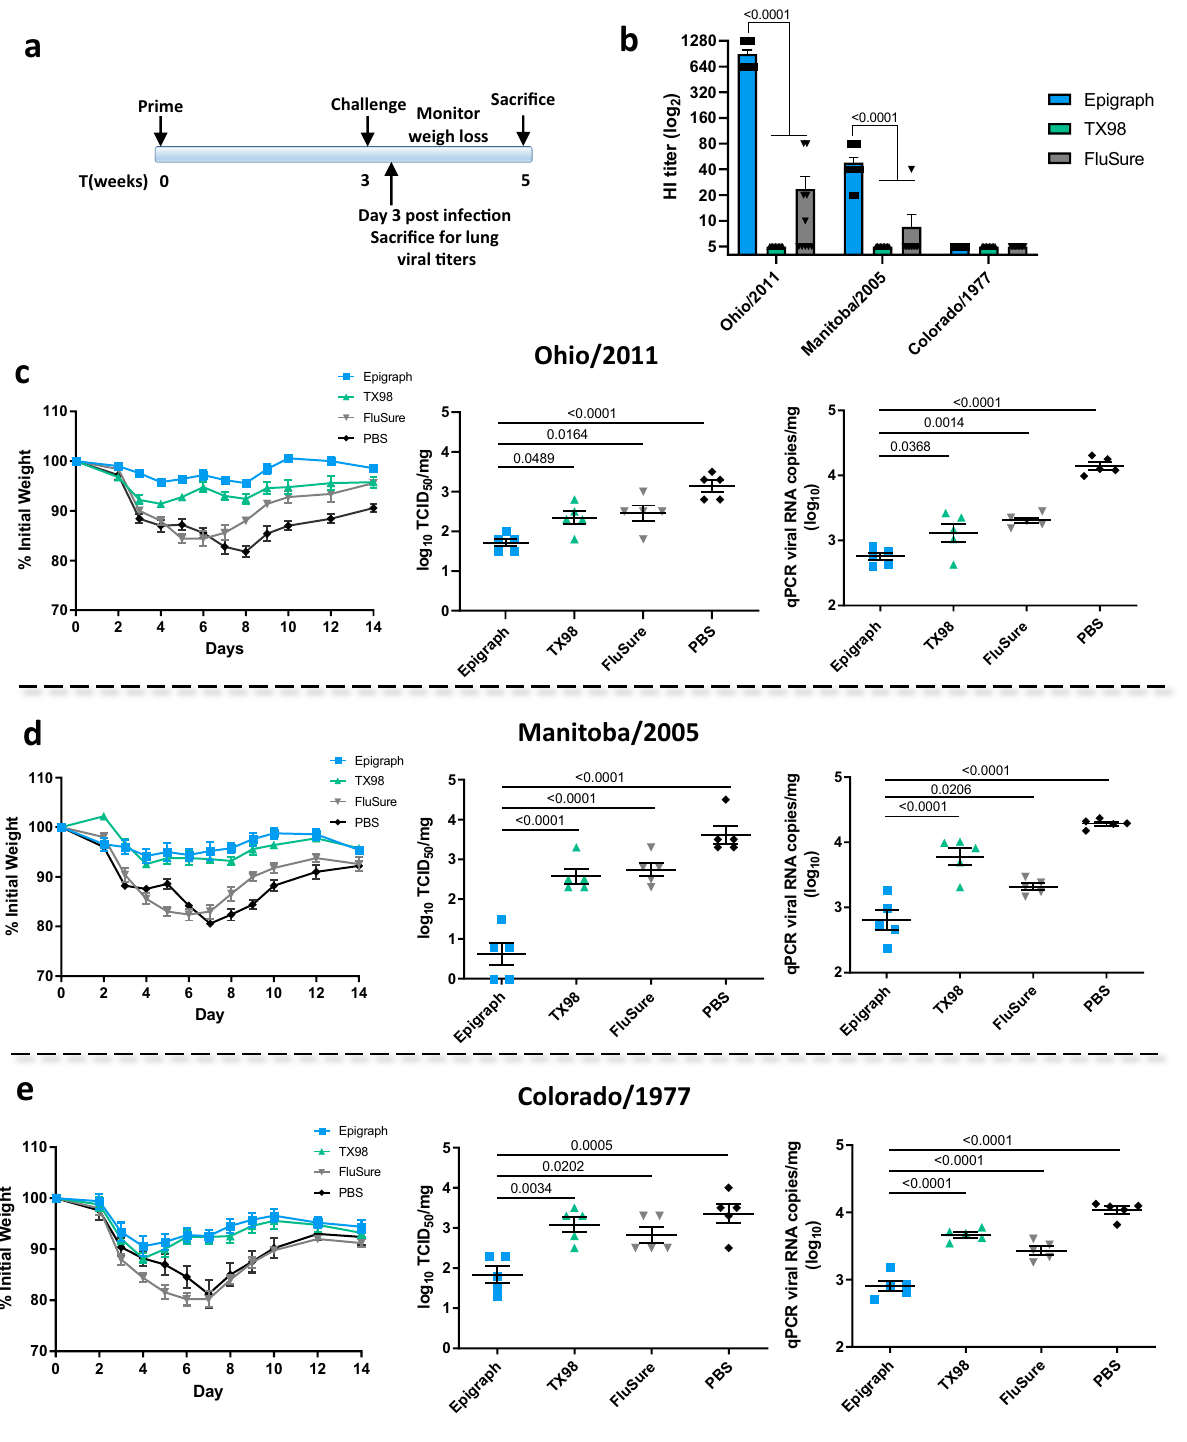
Fig. 4 Protection against challenge with divergent swH3 viruses. BALB/c mice ( n = 10) were vaccinated with 10 10 vp of HAdV-5-epigraph or HAdV-5- TX98, the commercial inactivated FluSure, or a PBS sham vaccine and challenged according to the timeline ( a ). An HI titer on mice sera was performed to examine the antibody response to the challenge virus strains after a single immunization ( n = 10; one-way ANOVA with Tukey ’ s multiple comparisons compared to the epigraph group) ( b ). Mice were challenged intranasally ( n = 10) with 10 4 TCID 50 of Ohio/2011 ( c ), 10 5 TCID 50 of Manitoba/2005 ( d ), or 10 3.5 TCID 50 of Colorado/1977 ( e ) and monitored for weight loss over 14 days. Mice that reached 25% weight loss were humanely euthanized. Three days post infection, fi ve mice per group were sacri fi ced to examine lung viral titers by TCID 50 and qPCR ( n = 5; one-way ANOVA with Tukey ’ s multiple comparisons compared to the epigraph group). Data are presented as the mean with standard error